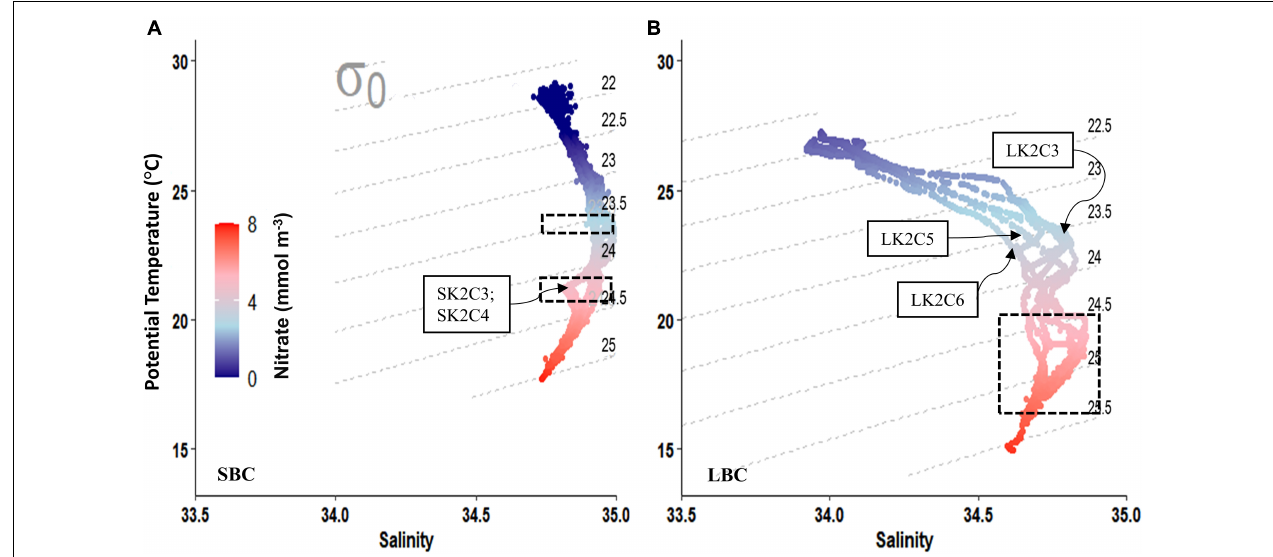
FIGURE 6 | Color coded nitrate concentrations were plotted on a temperature-salinity diagram to show different relationships of nitrates with isopycnals, σ θ (kg m − 3 ) during (A) small billow case (SBC) and (B) large billow case (LBC). Dashed boxes highlight the nitrate profile in the approximate locations of KH billows. The profiles of the K2 sampling stations where billows occurred during the SBC were labeled in (A) . Since KH billows were observed throughout the time-series survey during the LBC, the temporal order of the profiles was indicated by a few sampling station labels in (B) . Isopycnal labels are on the left-hand side of each panel.